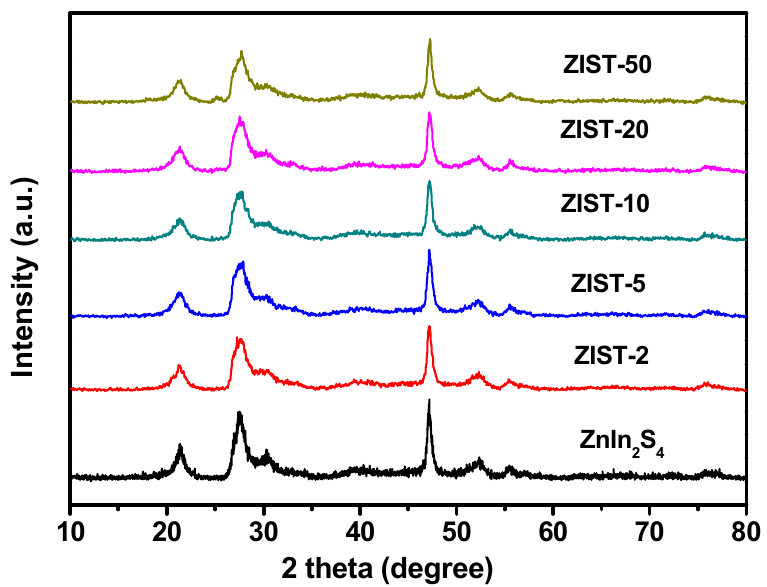
Figure 3. XRD patterns of ZnIn 2 S 4 /Ti 3 C 2 composites with different Ti 3 C 2 content.